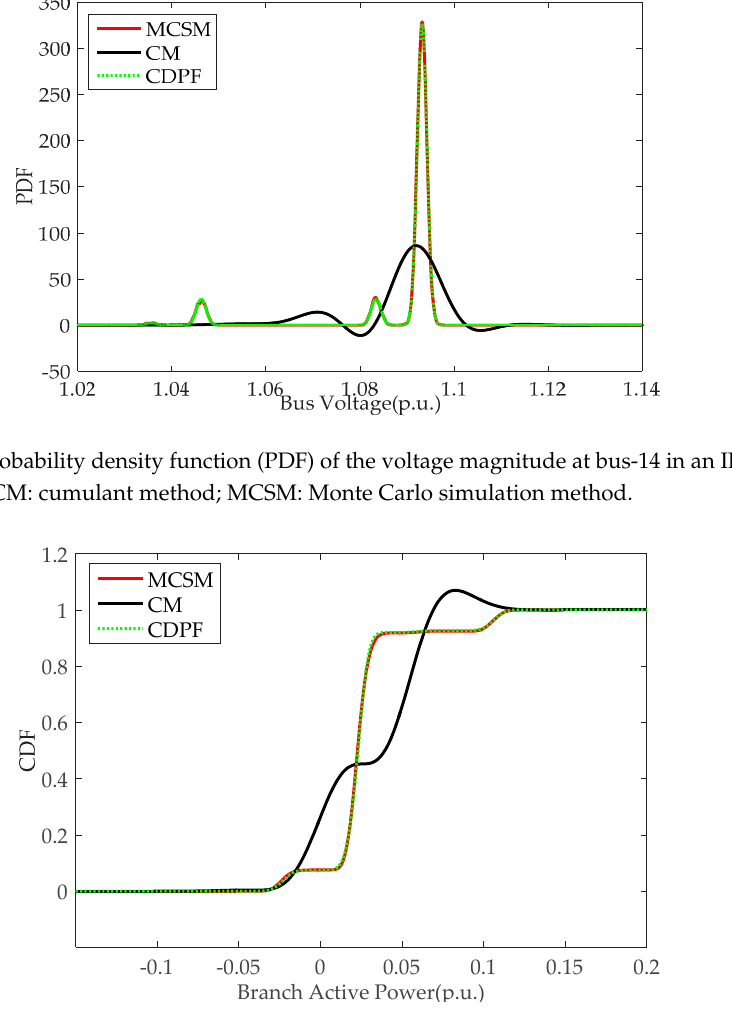
Figure 4. The cumulative density function (CDF) of the active power at branch 20 (13–14) in an IEEE 14-bus power system.